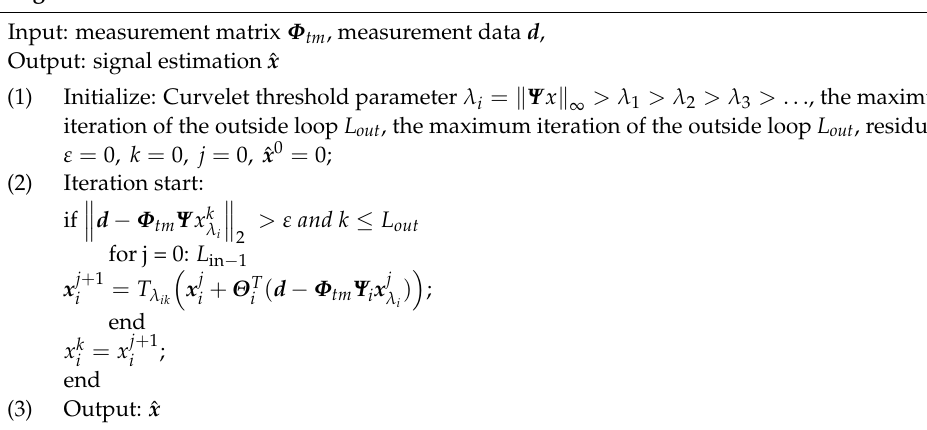
Algorithm 1 CS denoise based on the CRSI